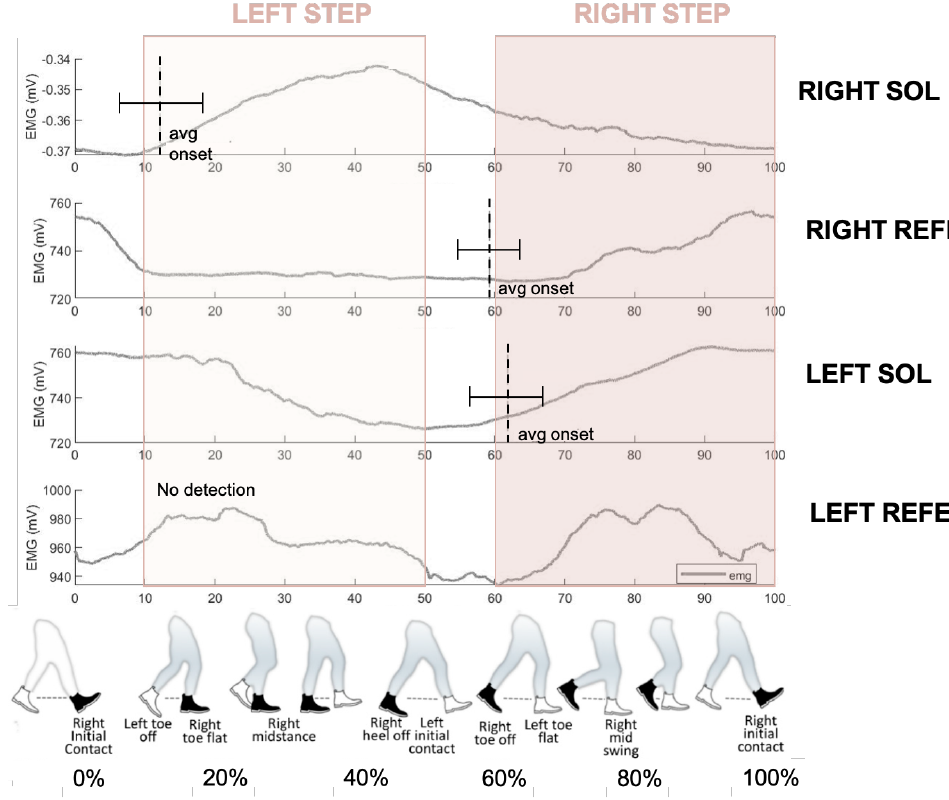
Figure 9. Average onset detection for the right and left Sol and ReFe .